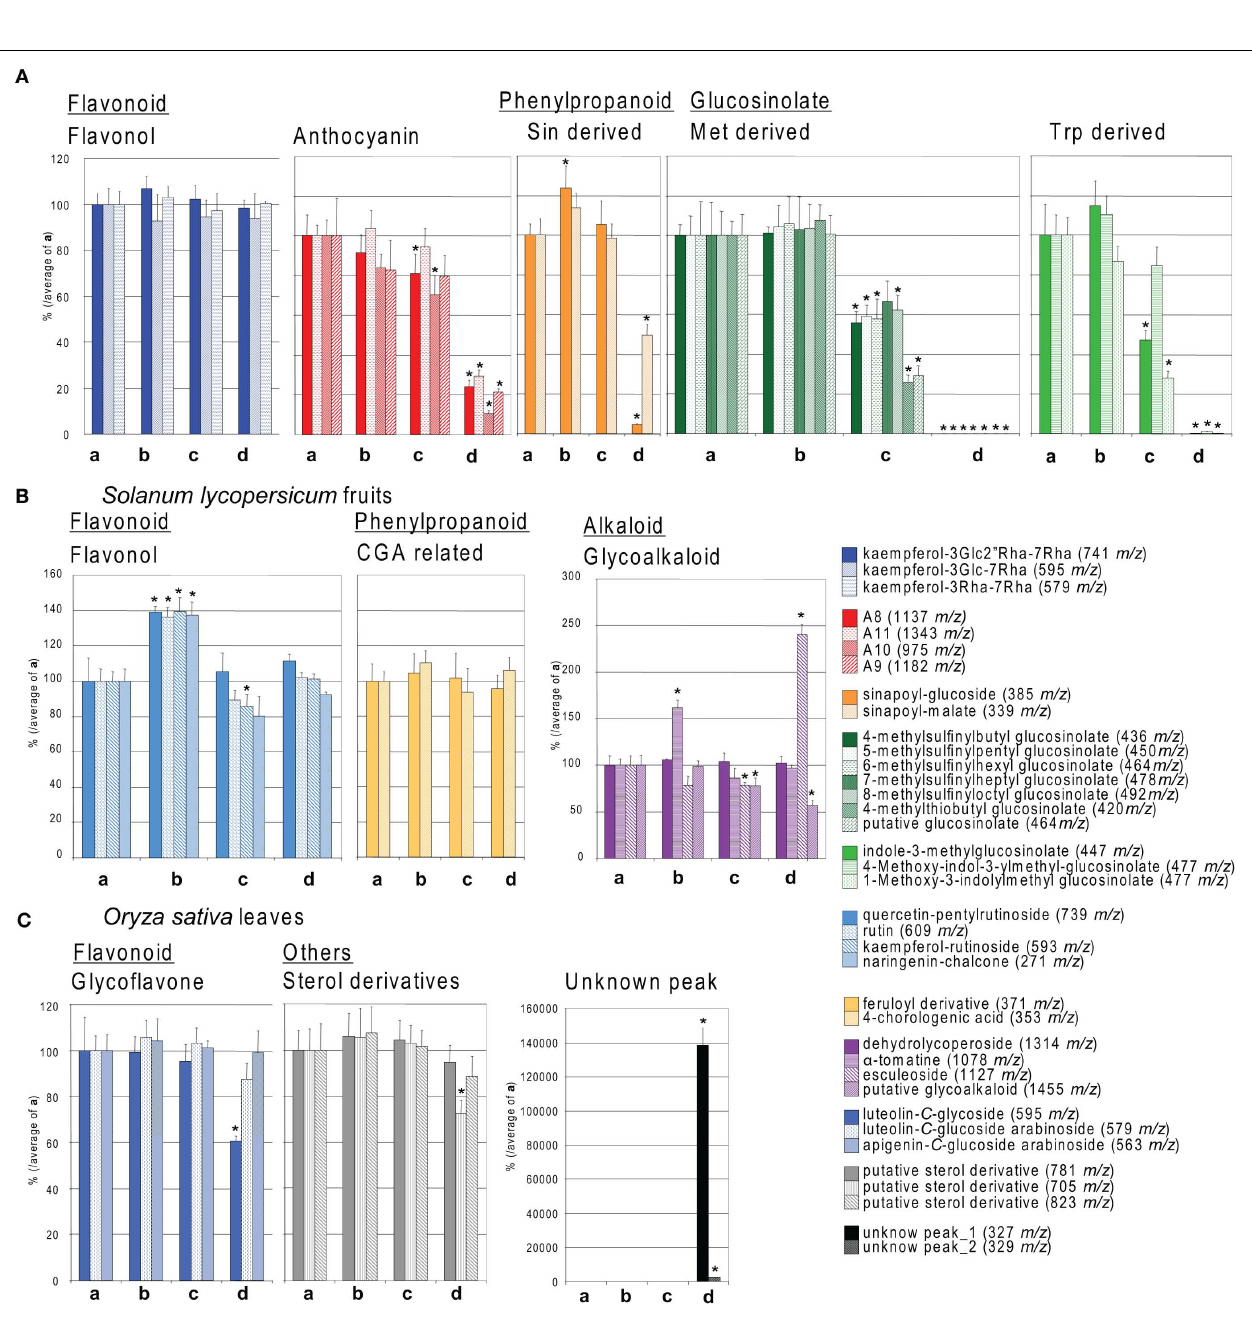
FIGURE 3 | Comparison of secondary metabolite levels between different extraction methods. Relative peak area of the result described in Figure 2 of (A) Arabidopsis leaves, (B) tomato fruits, and (C) rice leaves, are shown. Y -axis indicates percentage calculated by average of peak area of treatment (a) . (a–d) indicate different extraction methods as described in Figure 2 and Section “Materials and Methods.” Blue related colors indicate flavonoid related compounds (flavonol and glycoflavone). Red color indicates red-pigmented flavonoid related compounds (anthocyanin).Yellow,